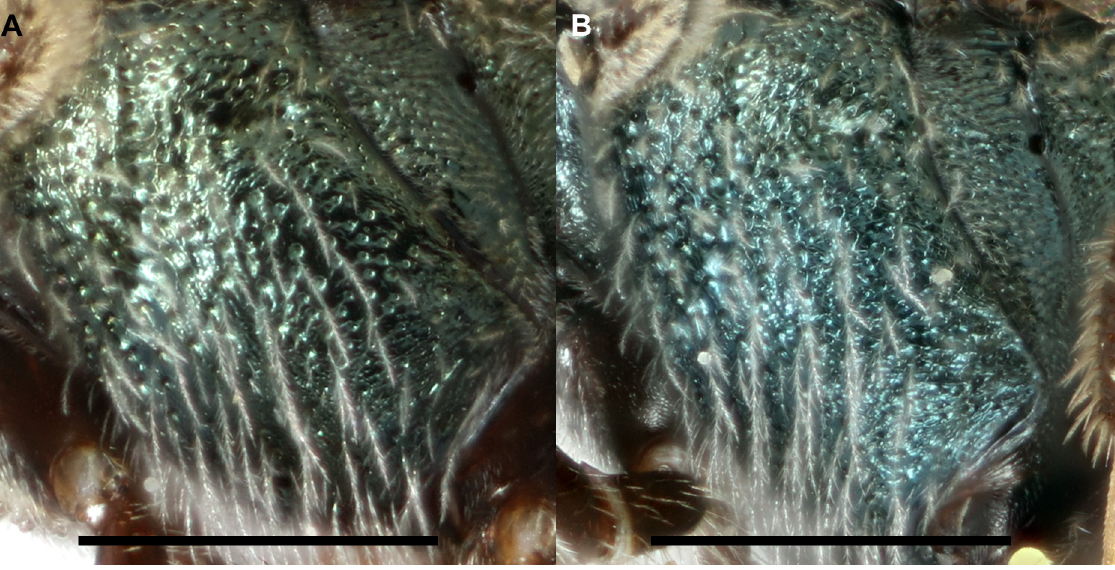
Fig. 98. Mesepisternum. A . Lasioglossum diabolicum sp. nov., ♀, shiny with distinct round punctures. B . L. tegulare (Robertson, 1890), ♀, dull and rugulose. Scale bars = 0.5